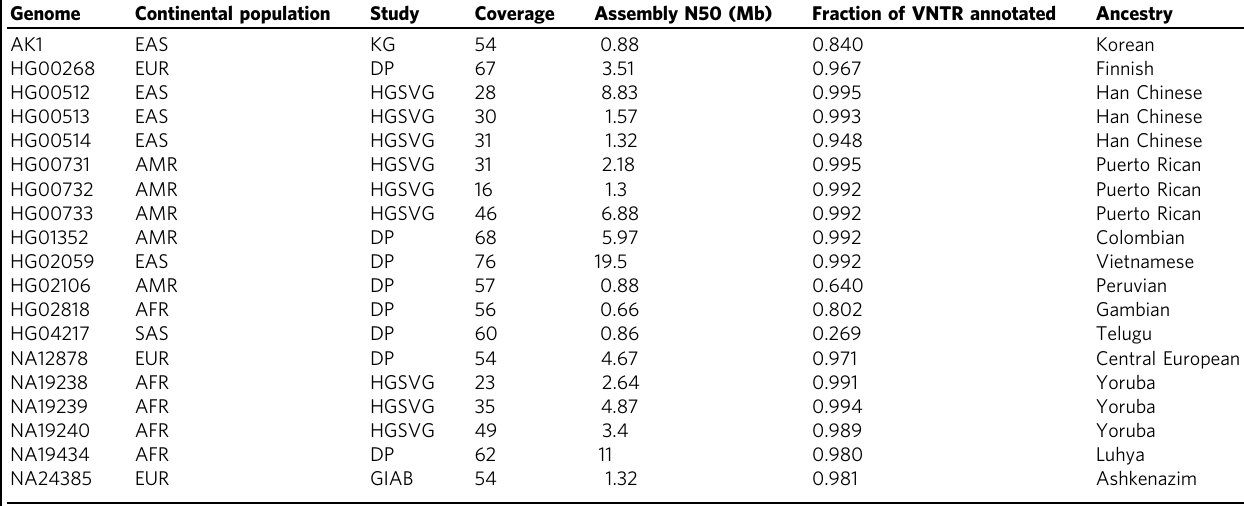
Table 1 Source genomes for the RPGG.